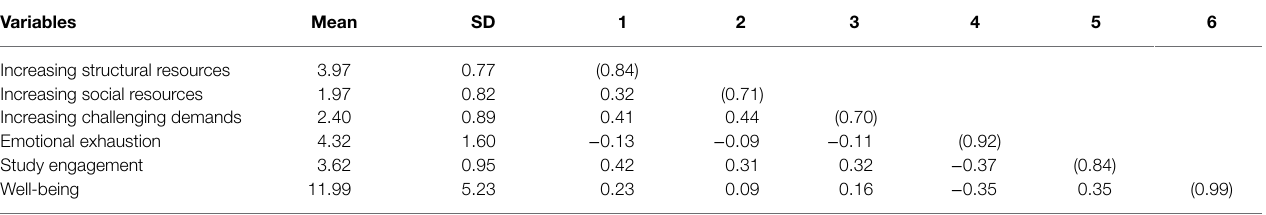
TABLE 4 | Study variables, means, standard deviations, correlations, and Cronbach’s alphas ( N = 2,822).